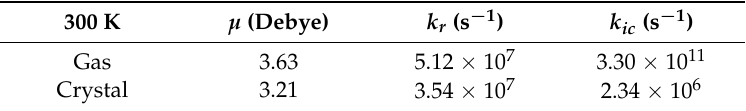
Table 2. The calculated electric transition dipole moments ( µ ), radiative rate constants ( k r ) and nonradiative rate constants ( k ic ) of TPPM-4M in the gas phase and the crystal phase ( T = 300 K).